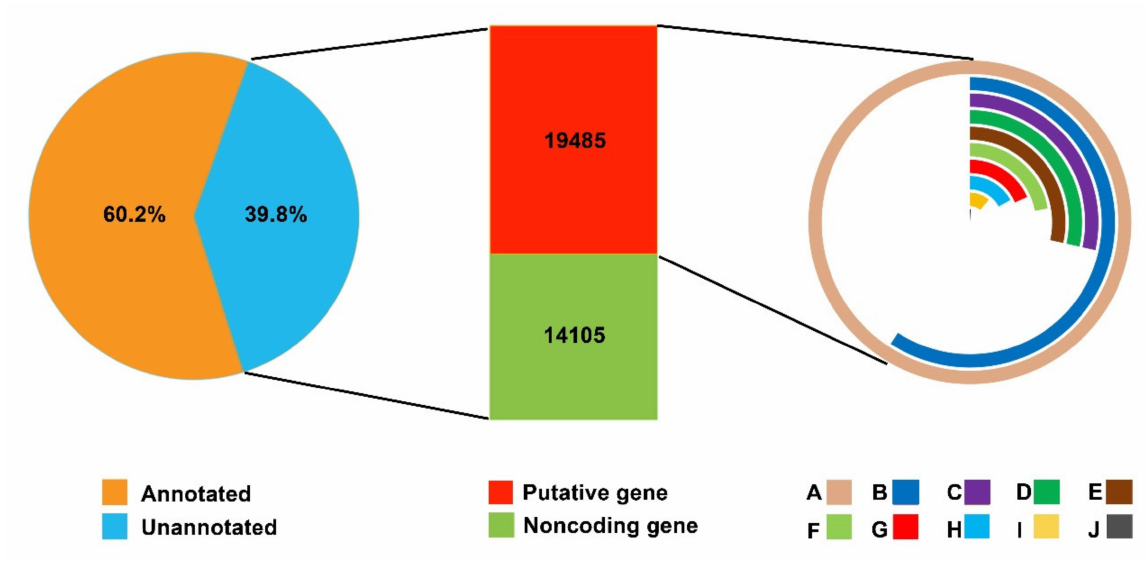
Figure 2. RNA-seq analysis of two inbred lines and annotation source. A: total numbers of genes; B: homologous analysis of DNA sequence (nr); C: SignalP prediction; D: TMHMM prediction; E: amino acid sequence prediction; F: homologous analysis of amino acid sequence; G: homologous analysis of DNA sequence (UniProt); H: PFAM prediction; I: homologous analysis of amino acid sequence (UniProt); J: RNA MMER